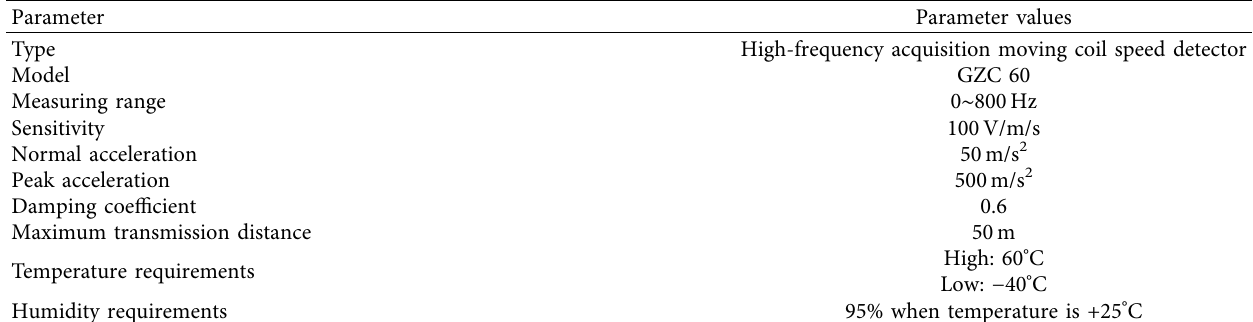
Table 2: Parameters of the gathering device.